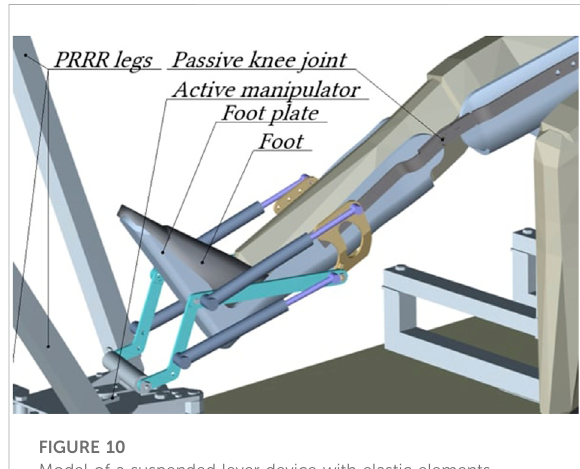
FIGURE 10 Model of a suspended lever device with elastic